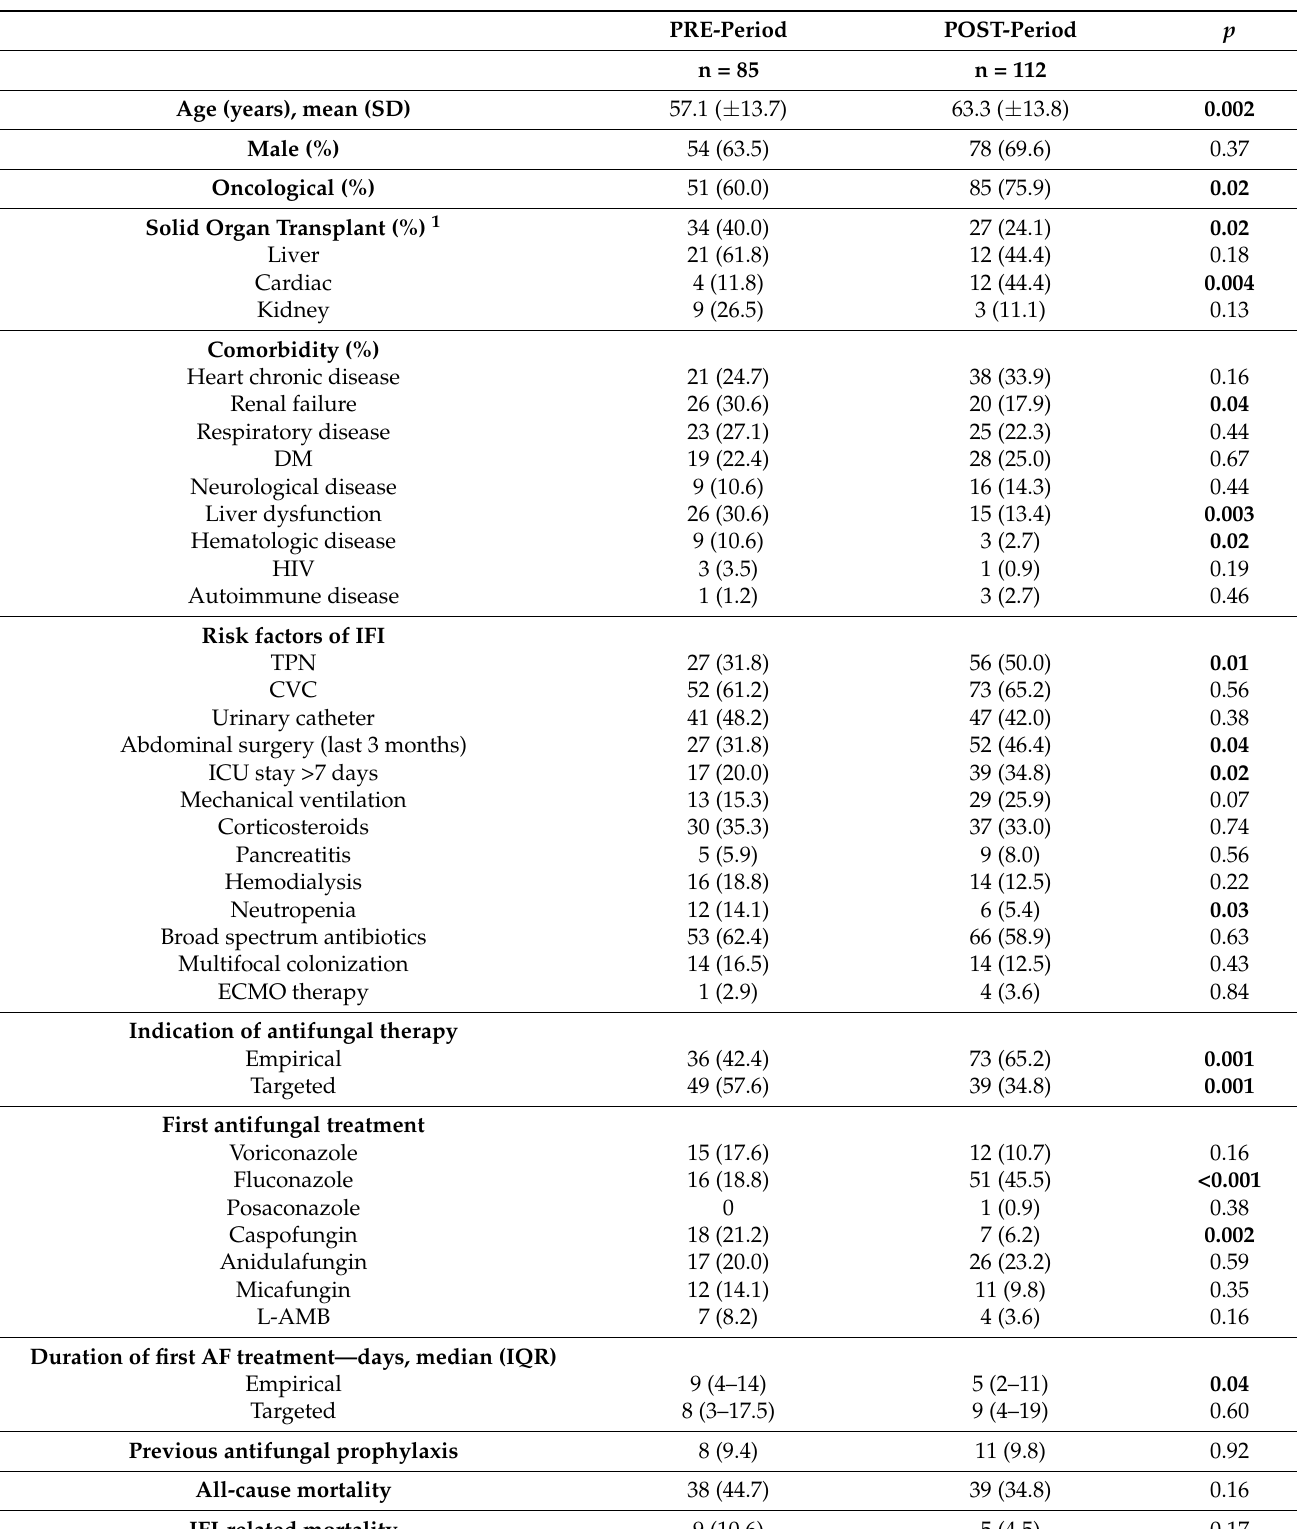
Table 2. Demographic and clinical characteristics of 197 included